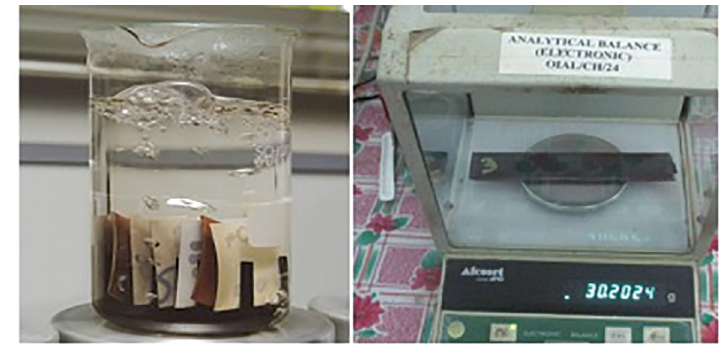
Figure 6: (a) soaked specimen and (b) water absorbed